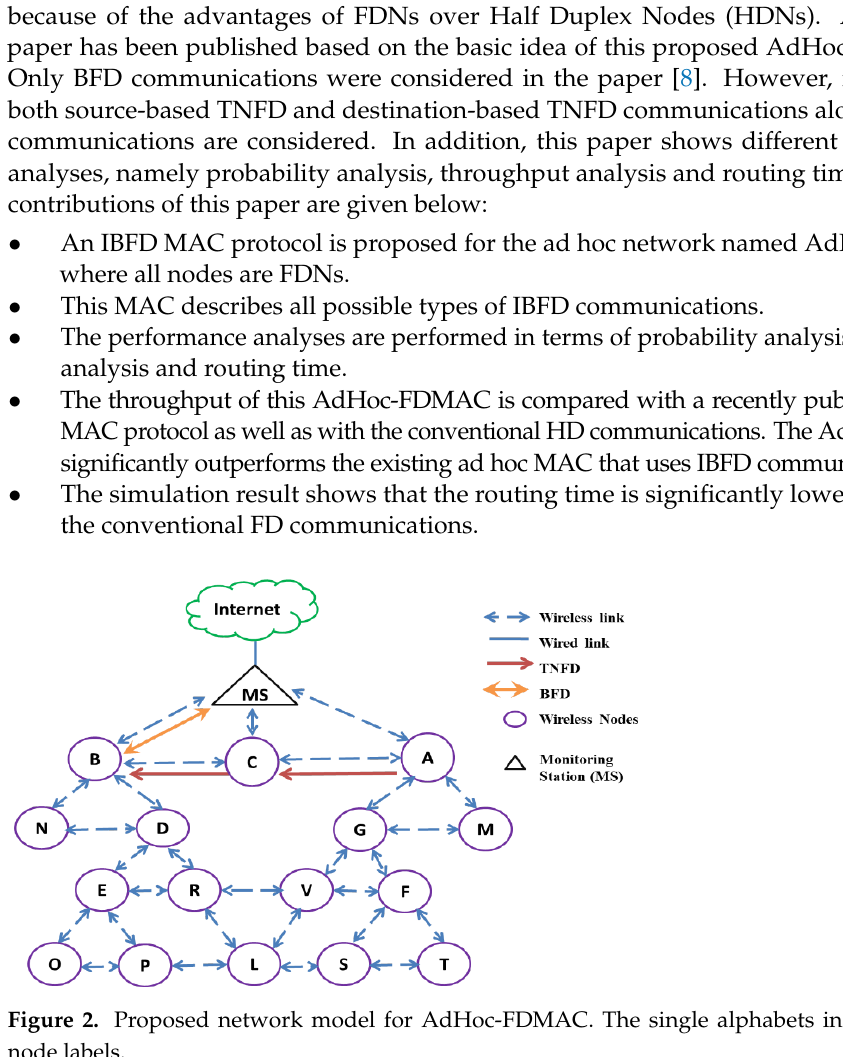
Figure 1. Different types of IBFD transmission: ( a ) BFD, ( b ) destination-based TNFD, ( c ) source- based TNFD.